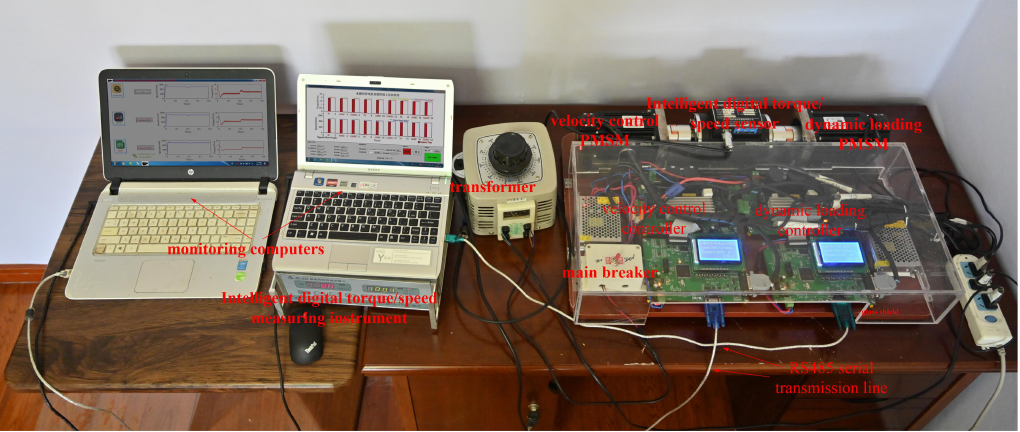
Figure 6. The physical system diagram of experiment